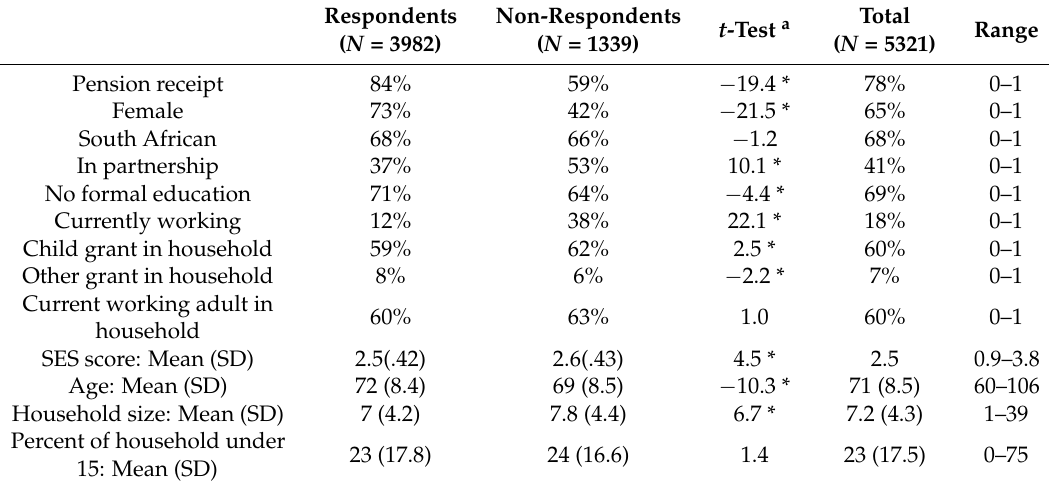
Table 3. Description of adults 60+ permanently in the Agincourt sub-district by response status to WHO-SAGE,